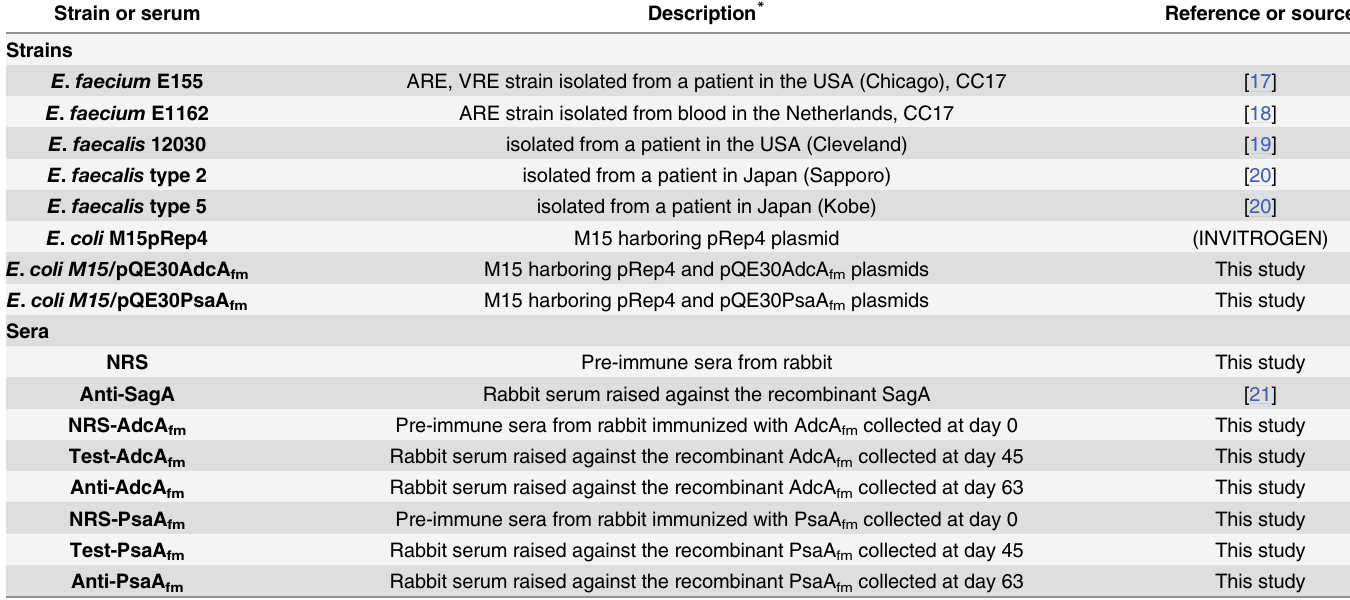
Table 1. Bacterial strains and sera used for this